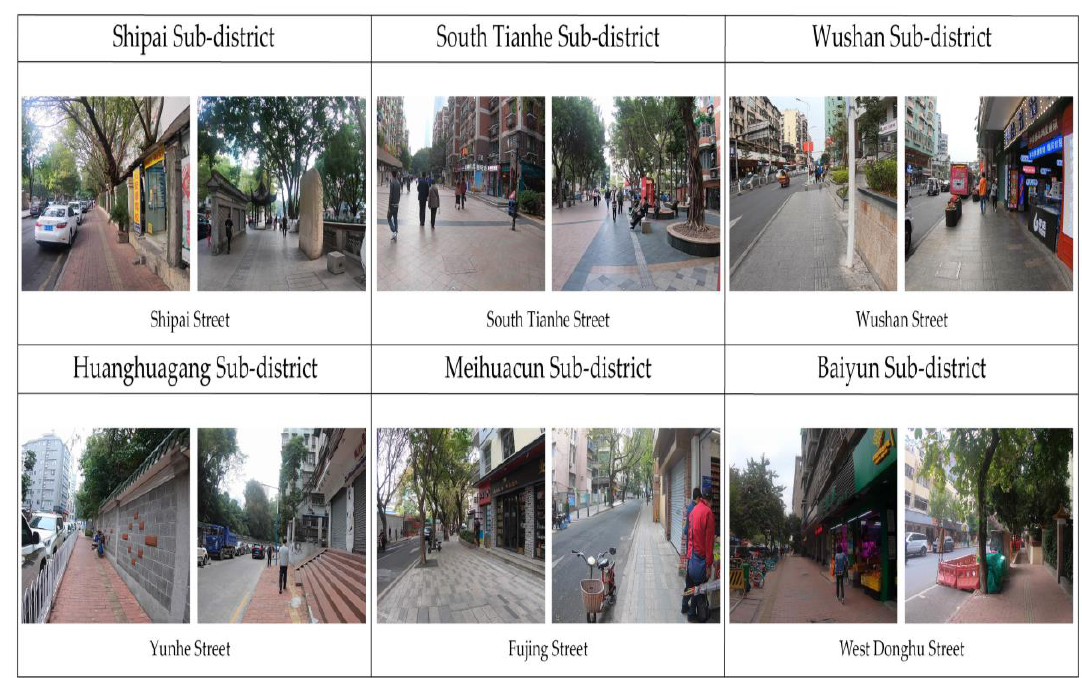
Figure 3. Photographs of six different street environments.